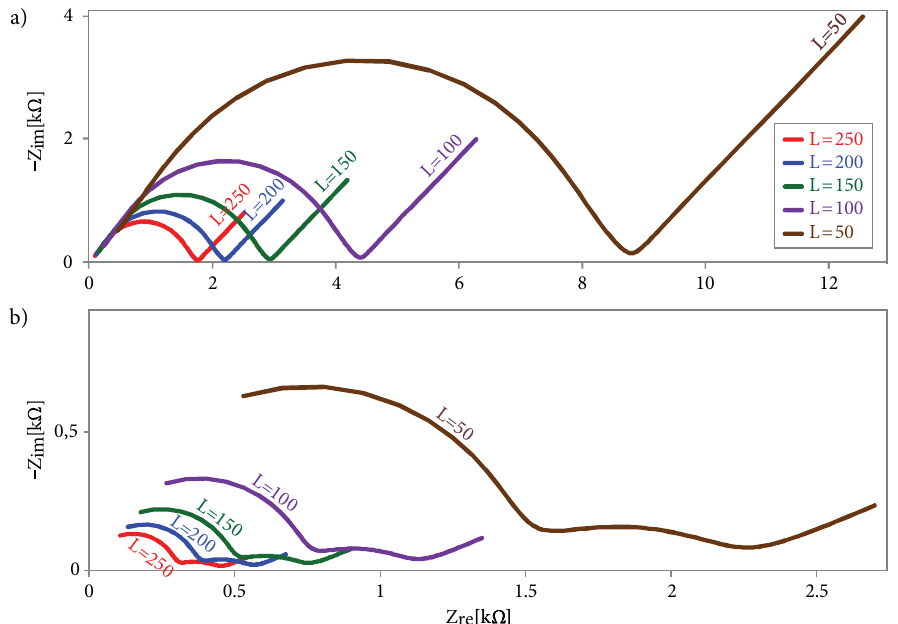
Fig. 6. Model simulation of concrete reinforcement impedance spectra distribution in concrete: a) without additive, b) with